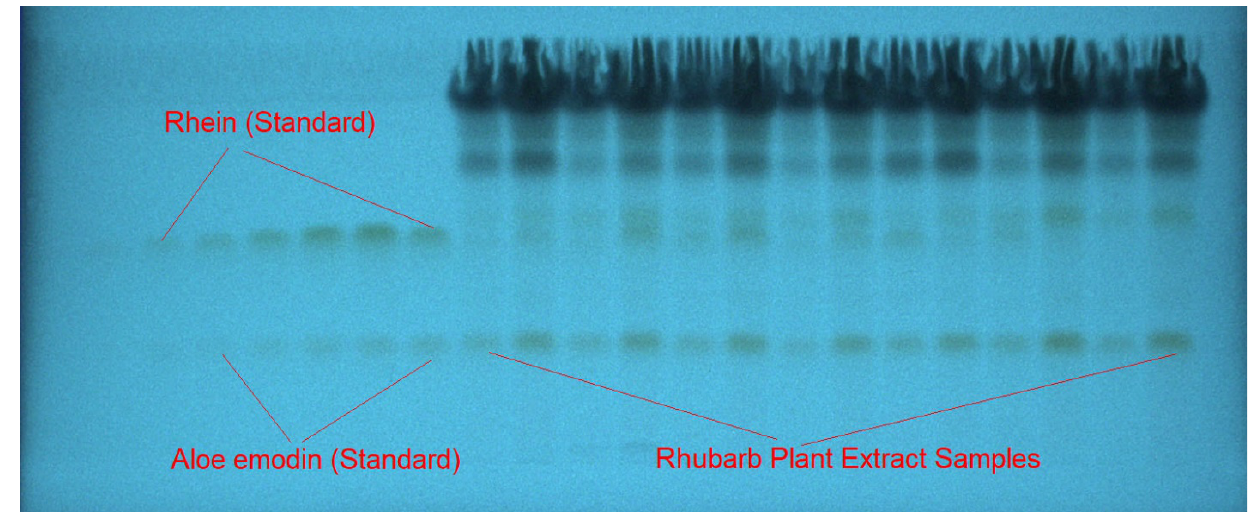
Figure 3. Developed thin-layer chromatography (TLC) plate for standard rhein, standard aloe- emodin, and Rhubarb plant extract samples developed using ethanol/water (60:40 v / v ) as the sustainable mobile phase for the sustainable reverse-phase HPTLC